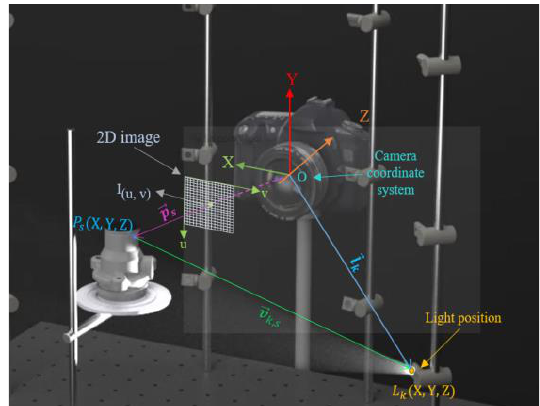
Figure 3. The geometry of computing light direction at each surface point given the light position L k and surface points P s .